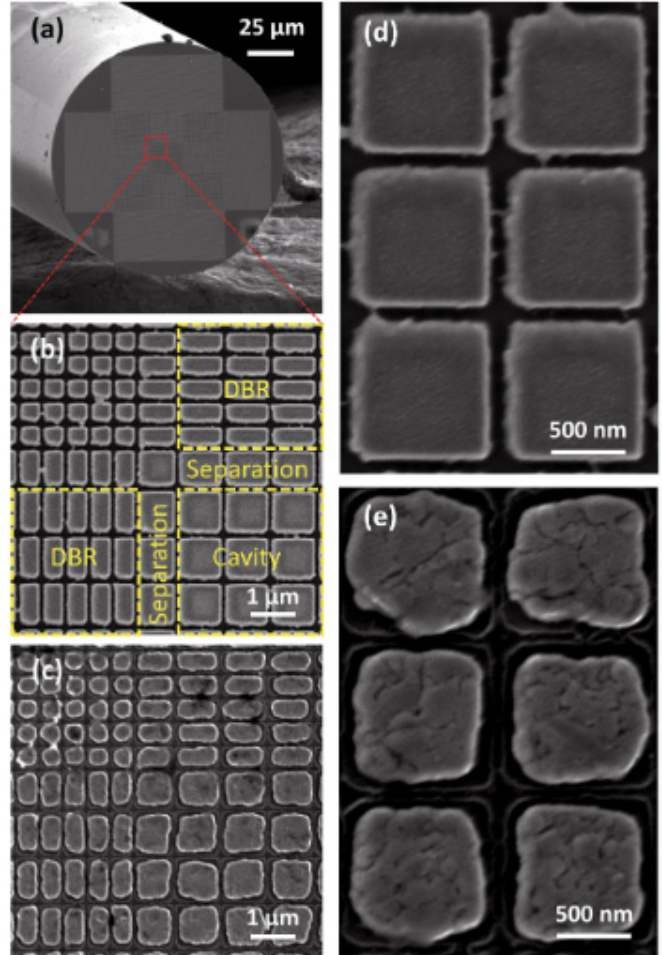
Figure 33. SEM images of the fabricated Au nanopatch array on a single-mode optical fiber: ( a ) the fiber end-face with a plasmonic crystal cavity, a corner section of the plasmonic cavity ( b ) before thermal loading and ( c ) after 500 cycles of thermal loading, and the square Au nanopatches in the plasmonic cavity ( d ) before thermal loading and ( e ) after 500 cycles of thermal loading. Reprinted with permission of [96].